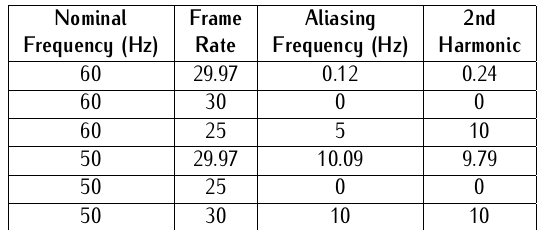
Table 1. Aliased Frequency for a given Video Frame rate with different nominal frequency.